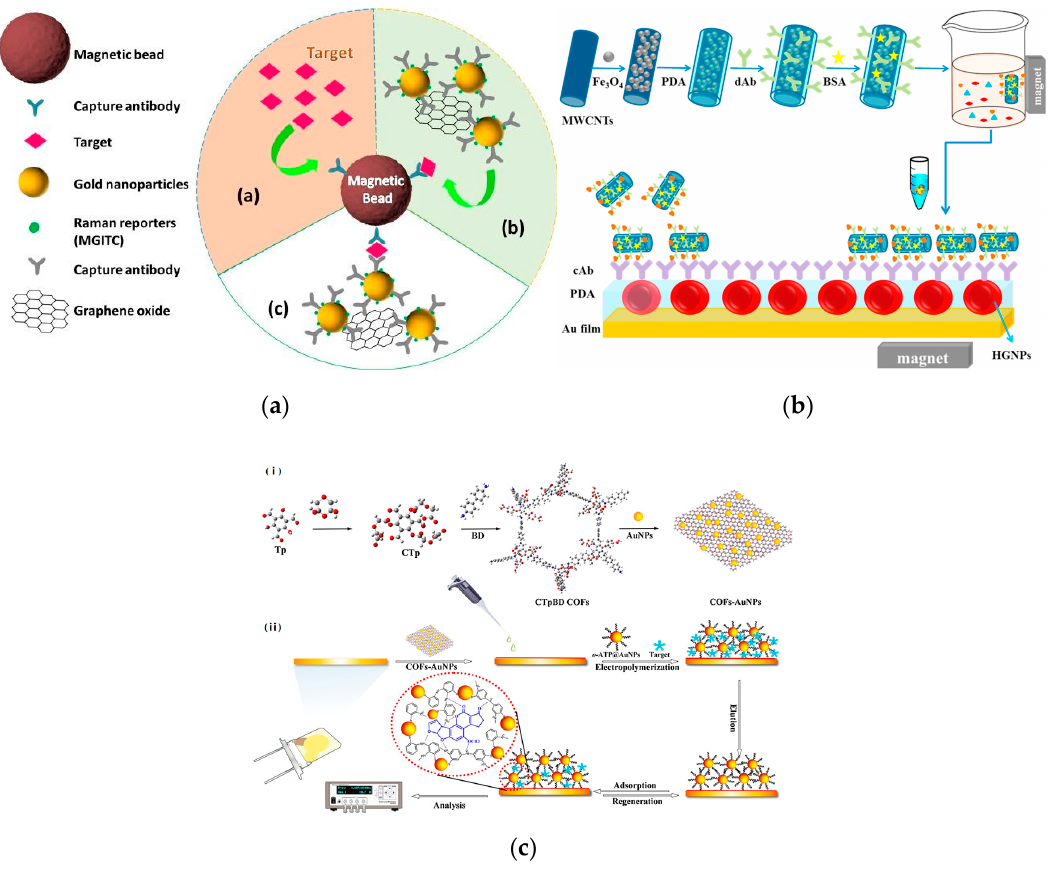
Figure 12. ( a ) The SERS strategy based on GO/AuNPs signal amplification for quantification of cTnI [169]. ( b ) The SPR biosensor based MMWCNTs-PDA immune probe for the detection of cTnI [171].